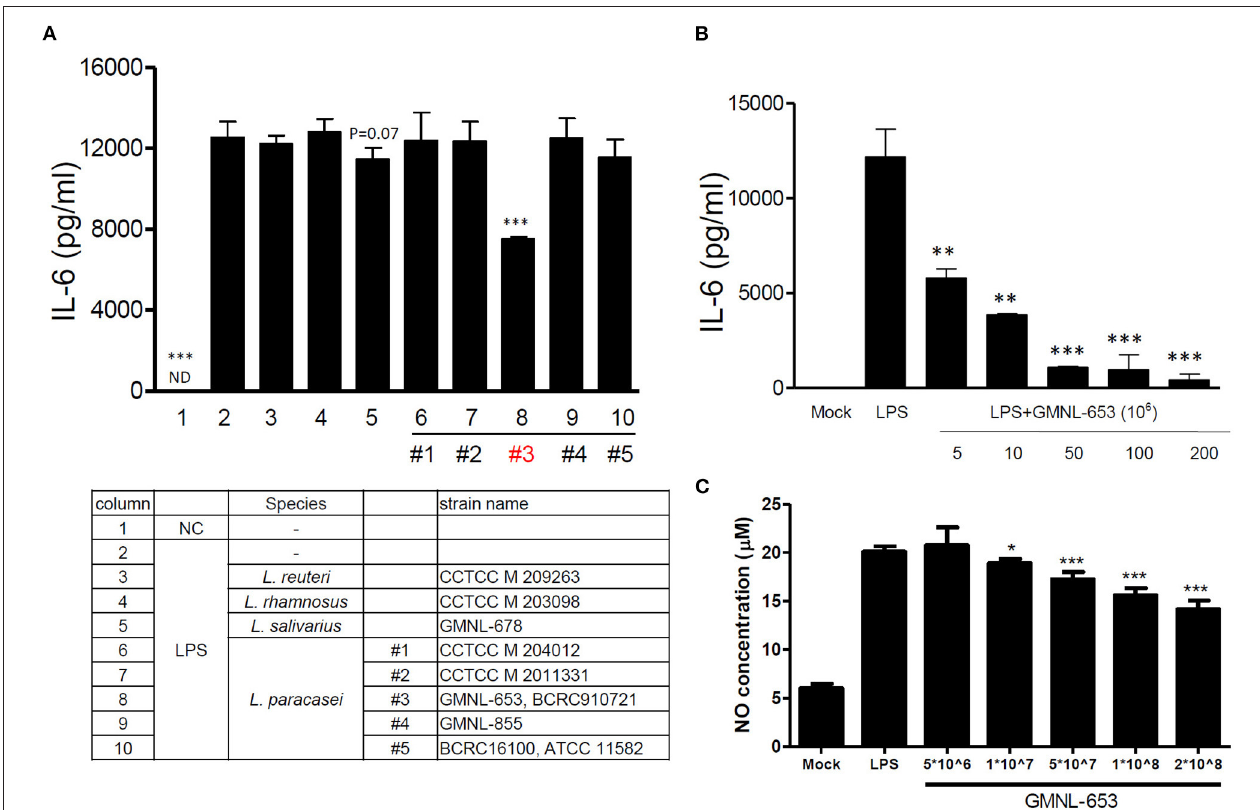
FIGURE 1 | Heat-killed probiotics reduced IL-6 and NO levels through LPS stimulation in mouse RAW 264.7 macrophages. An appropriate number of cells were seeded in a 24-well plate. Probiotics ( L. reuteri , L. rhamnosus , L. salivarius , and five strains of L. paracasei ) were cultured in MRS broth for 20h, with the bacterial concentration adjusted through centrifugation. These bacteria were heat killed (90 ◦ C for 30min) and then added to cells with or without LPS stimulation. After 20h, the culture supernatant was collected for measurement of the IL-6 production (A,B) and NO (C) . * P < 0.05, ** P < 0.01, and *** P < 0.001 compared with the group treated with LPS